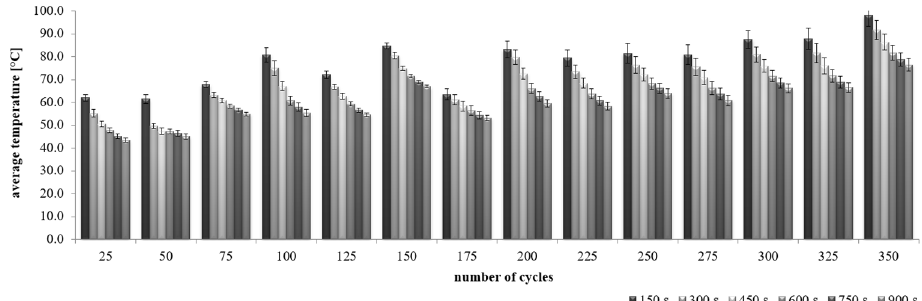
Figure 17. Change in the average temperature of CC-1 concrete during the cooling process.